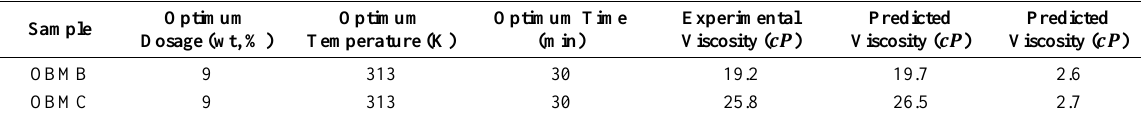
Table 9. Validation of the